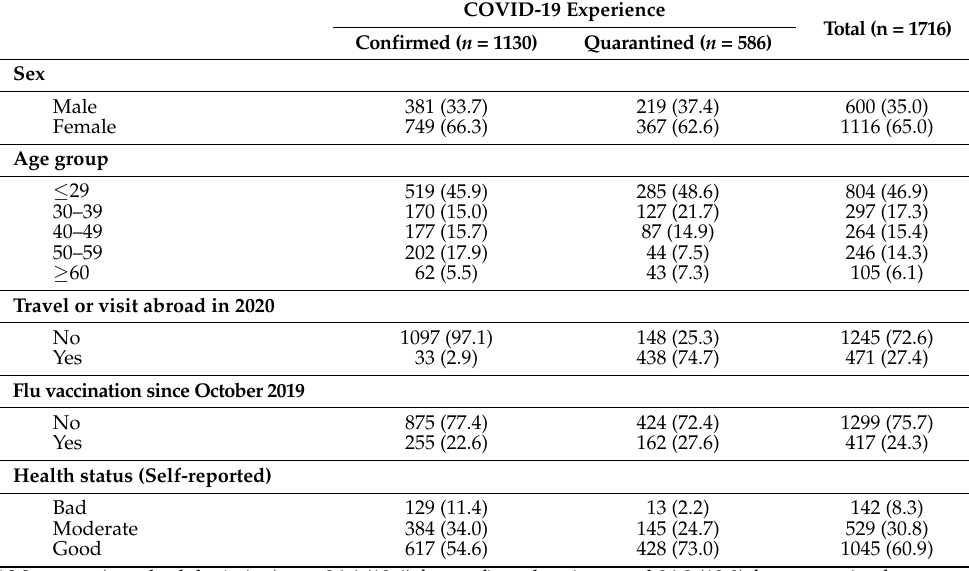
Table 2. Characteristics of survey participants